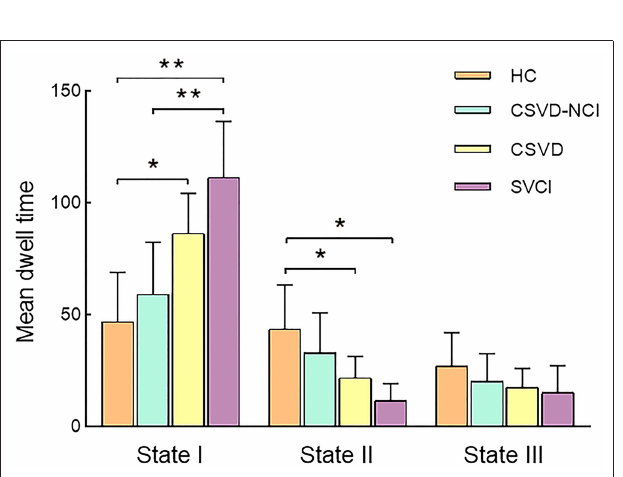
FIGURE 3 | Comparison of the mean dwell time in each state between the CSVD and HC groups as well among the CSVD subgroups by GLM. GLM, general linear model. * P < 0.05, ** P < 0.01.